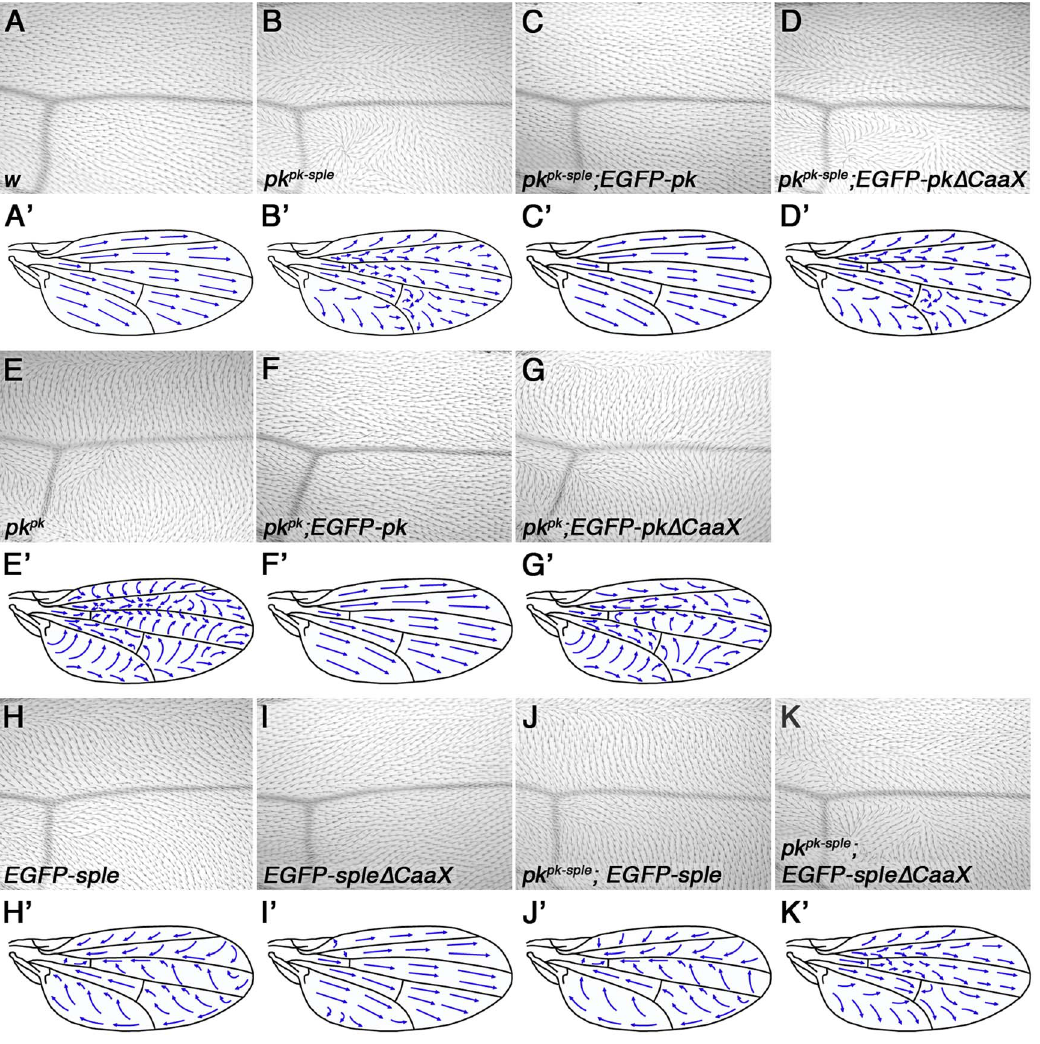
Figure 3. Requirement for Pk/Sple farnesylation in the wing. (A–K) Images of the region around vein 3 distal to the posterior cross-vein (A–K) and cartoons (A’–K’) of the dorsal surface of adult wings from wild type (A), pk pk-sple13 (B), pk pk-sple13 ; ActP - EGFP-pk/ + (C), ActP - EGFP-pk D CaaX/ + ; pk pk- sple13 (D), pk pk1 (E), pk pk1 ; ActP - EGFP-pk/ + (F), ActP - EGFP-pk D CaaX/ + ; pk pk1 (G), ActP-EGFP-sple/ + (H), ActP-EGFP-sple D CaaX/ + (I), pk pk-sple13 ; ActP - EGFP- sple/ + (J) and pk pk-sple13 ; ActP - EGFP-sple D CaaX/ + (K) flies. Mild swirls are present in the proximal regions of ActP-EGFP-sple D CaaX wings.